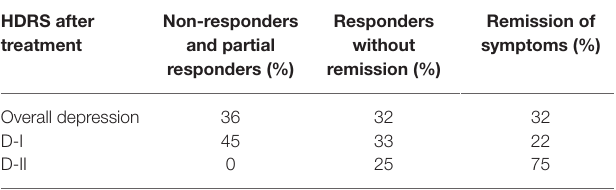
TABLE 1 | Differential improvement in scores in the Hamilton Depression Rating Scale (HDRS) passed to D-I and D-II patients after 8 weeks of antidepressant